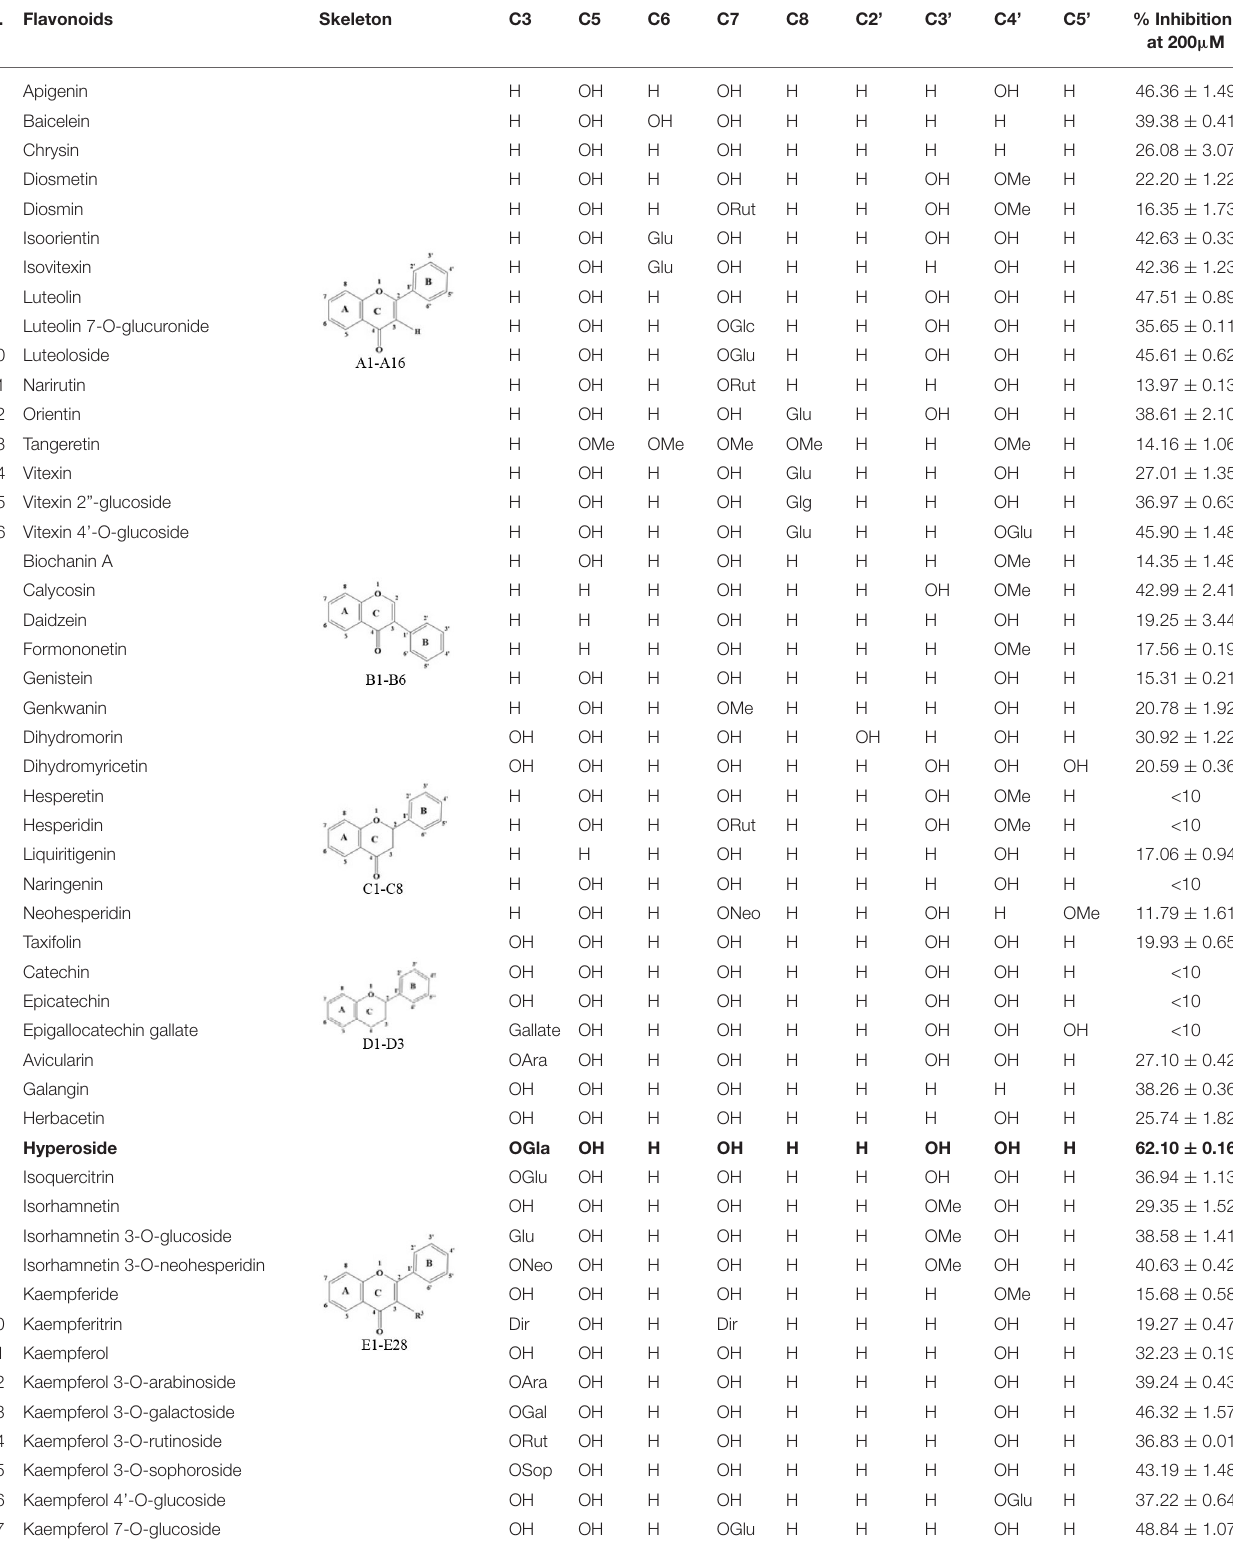
TABLE 1 | Inhibitory effects of flavonoids against